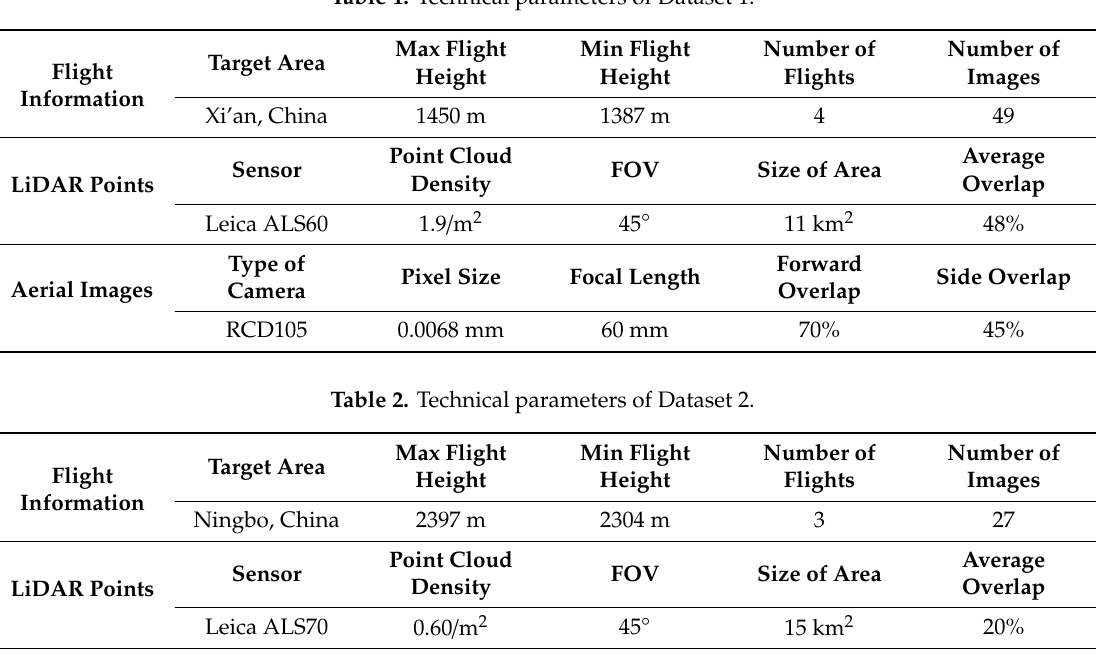
Table 1. Technical parameters of Dataset 1.